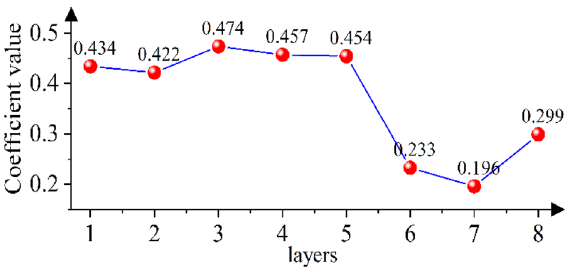
Figure 13. Coefficient values for different decomposition layers of the contaminated microseismic simulation signal.